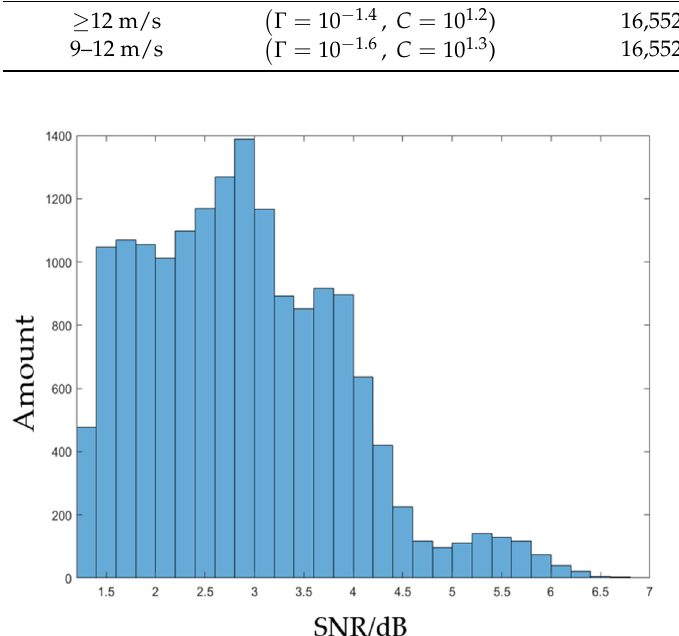
Table 4. Results of wind speed ≥ 12 m/s and 9–12 m/s after controlling the amount of data. Wind Speed